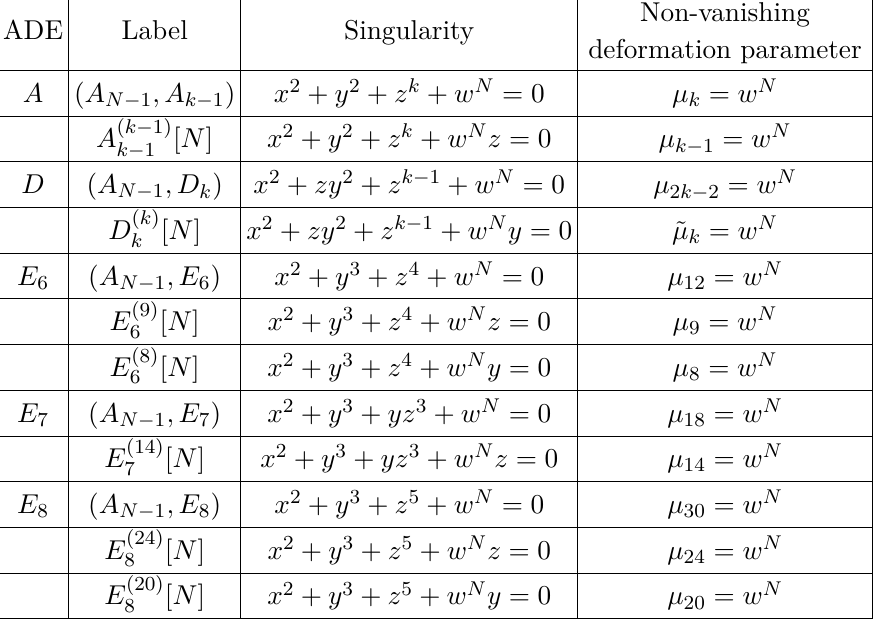
Table 1 . Quasi-homogeneous cDV singularities as ADE